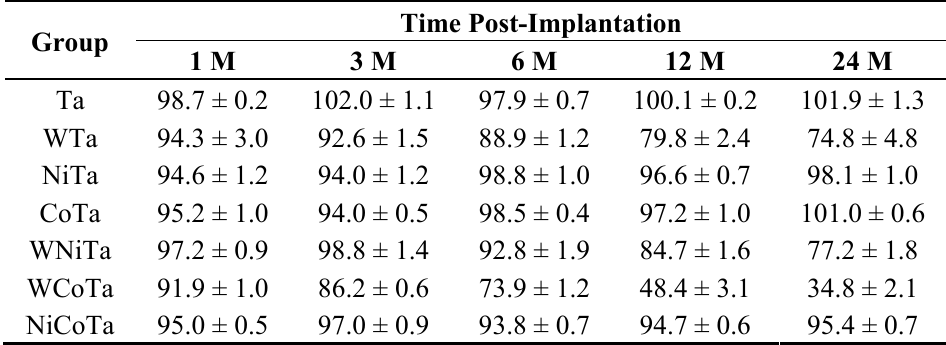
Table 5. Pellet recovery: percent of pre-implantation mass. Time Post-Implantation Group